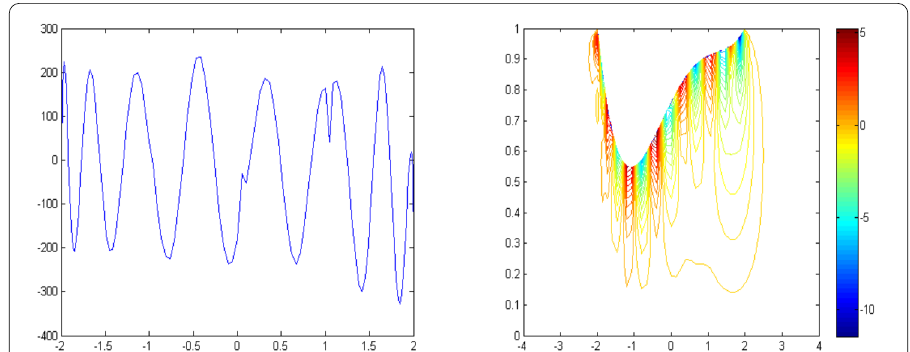
Figure 2 (left) Solution ψ of the integral equation (30); (right) Solution v 0 given by (22) in the domain Ω R , R =